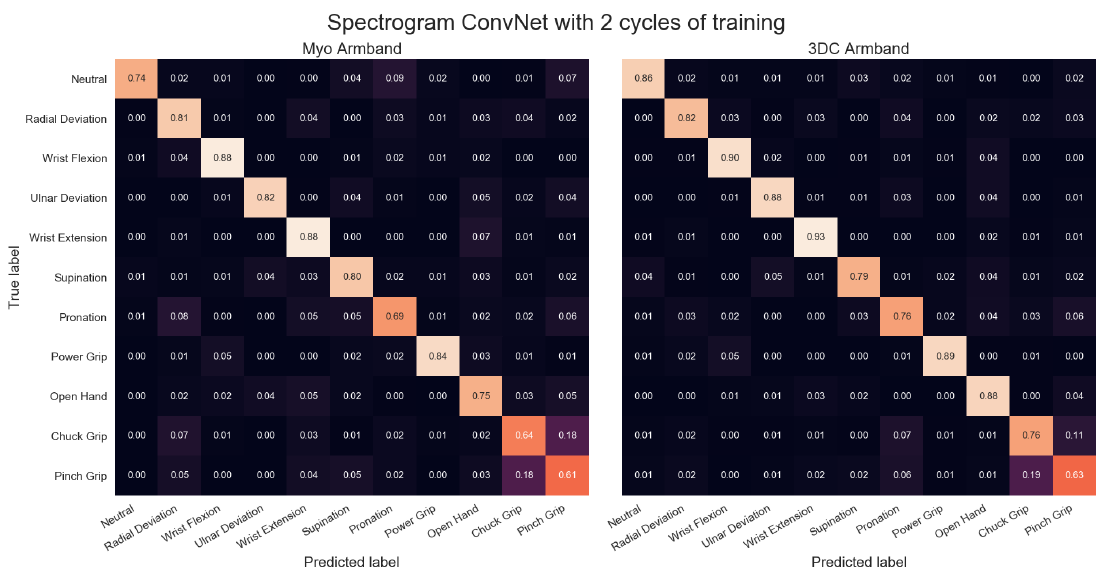
Figure A8. Confusion Matrices for the Myo and the 3DC Armband employing the Spectrogram ConvNet for classification and two cycles of training. Lighter is